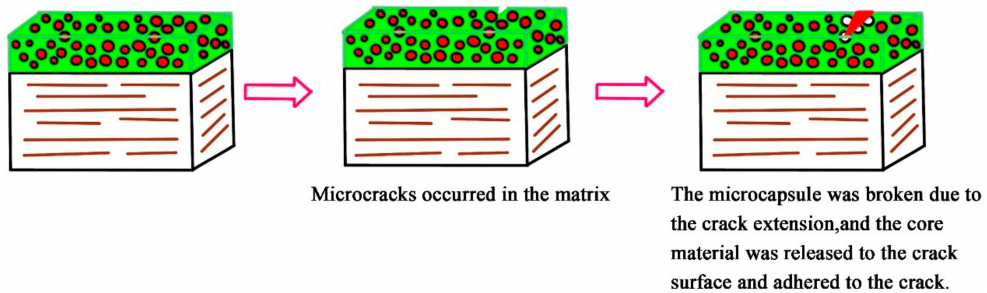
Figure 15. Self-healing mechanism of waterborne coating with microcapsules on the surface of European